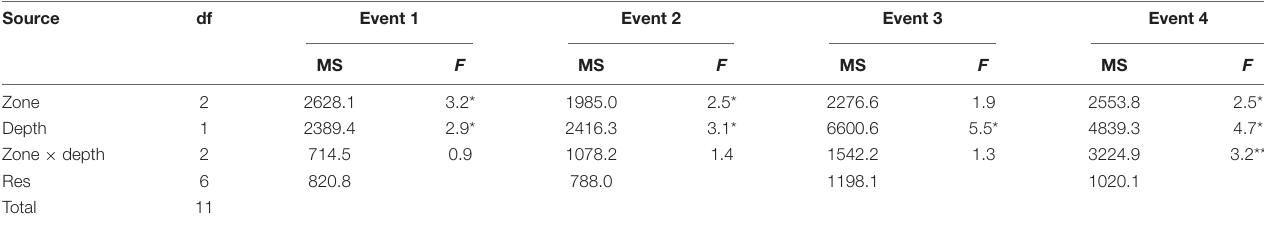
TABLE 4 | Results of the PERMANOVA conducted on square-root transformed abundance data of fish larvae recorded in the shallow nearshore of Sardinia Bay during the four different frontal